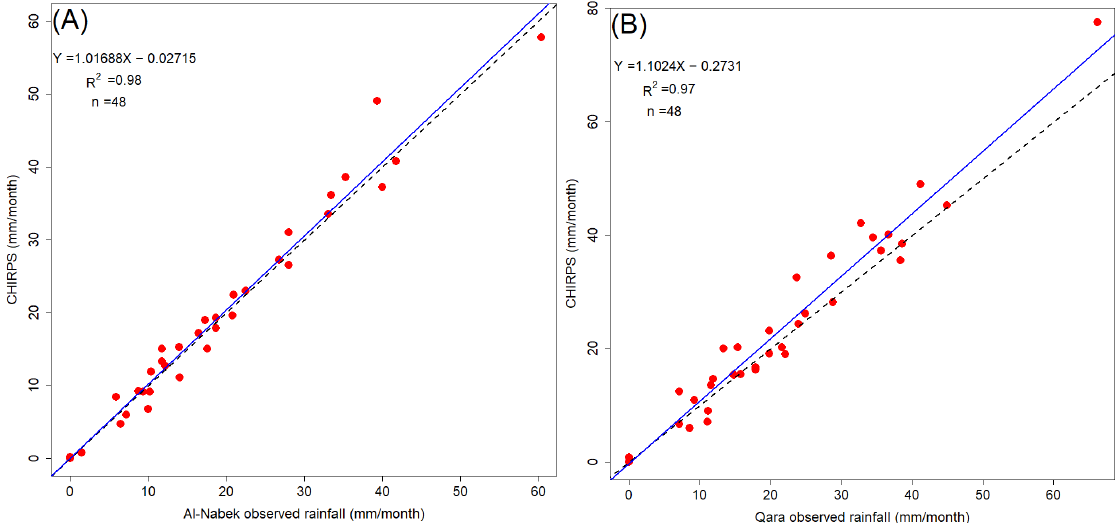
Figure 2. The linear correlation between the CHIRPS data and the precipitation data obtained from ( A ) Nabek and ( B ) Qara stations for the period between October 2009 and September 2013.